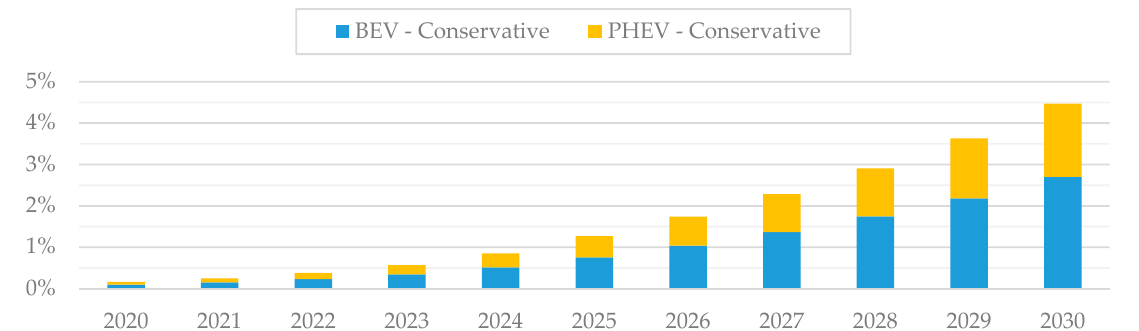
Figure 6. Estimated average BEV and PHEV penetration index on car stocks from 2020 to 2030 at Italian level (conservative scenario).